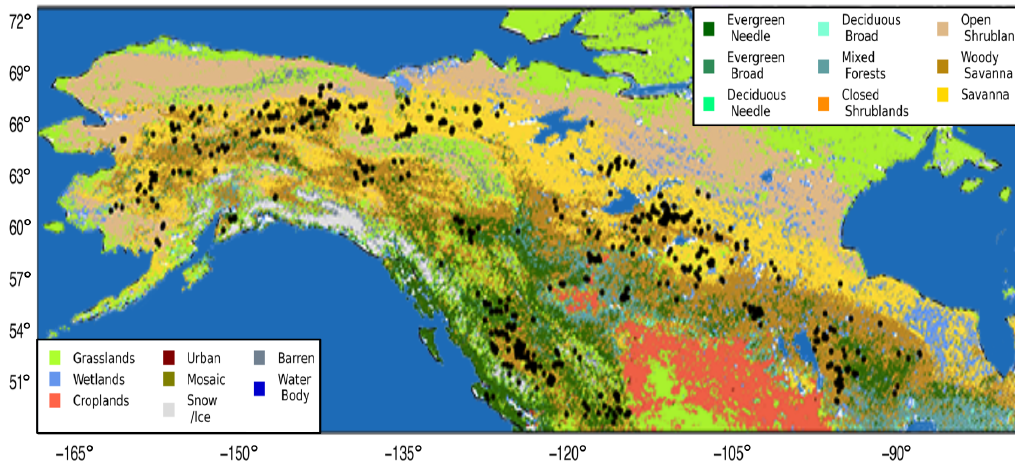
Figure 1. Map of all plumes used in this study (black dots) overlaid on the 2017 MODIS IGBP land cover types.